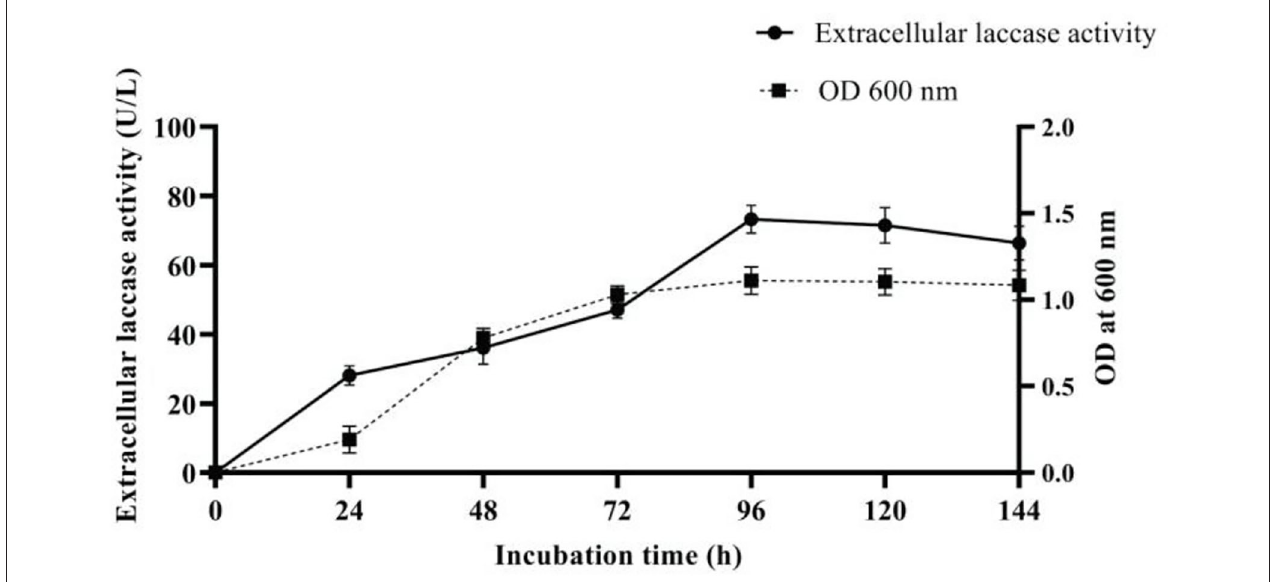
FIGURE 4 | Extracellular laccase production by strain AORB19 using optimized